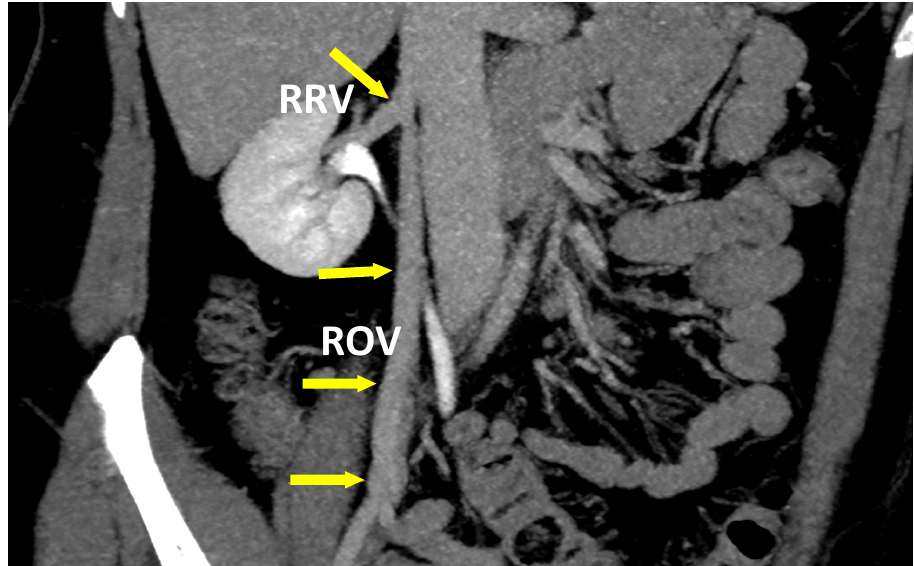
Figure 7. The coronal plane of a CT-V scan in a patient with atypical ROV outflow. Blood from ROV is drained into RRV.